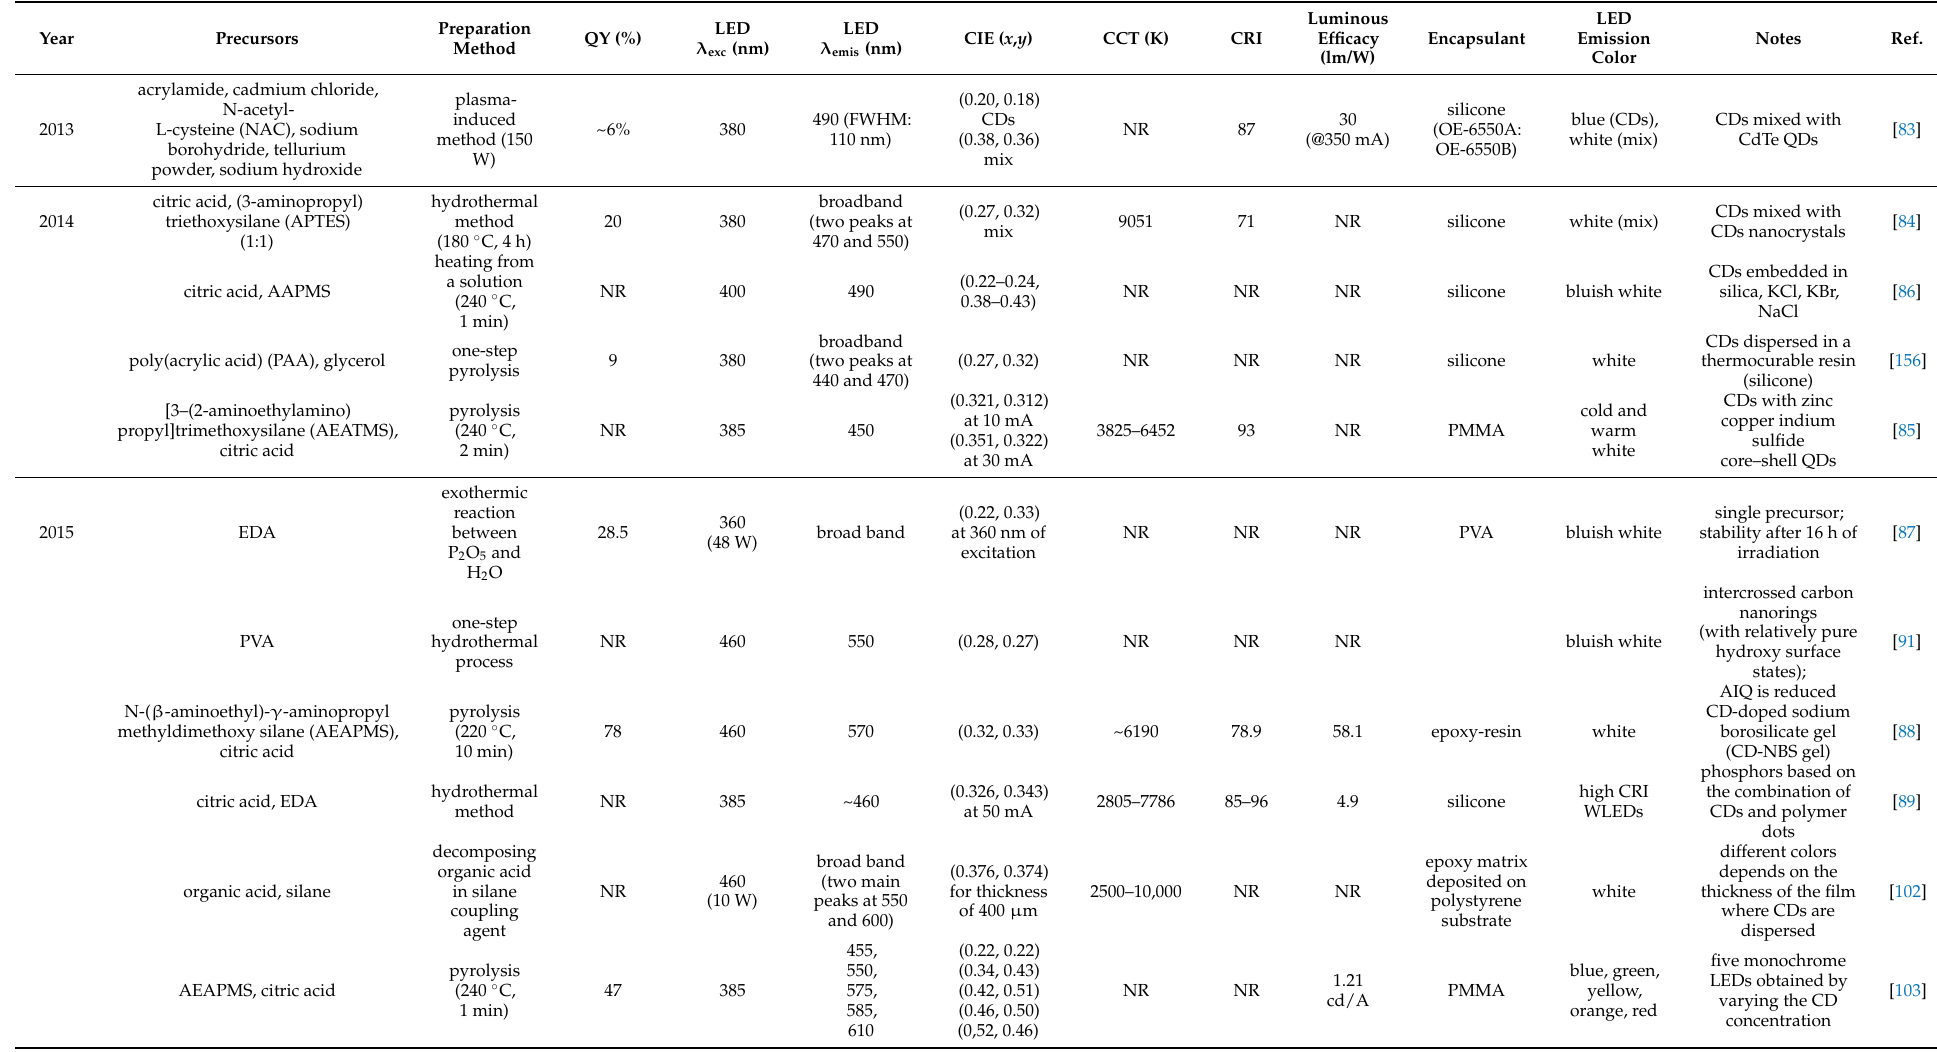
Table 1. Optical parameters, precursors, synthesis methods, and other parameters of CD-based color converter LEDs; (NR = not